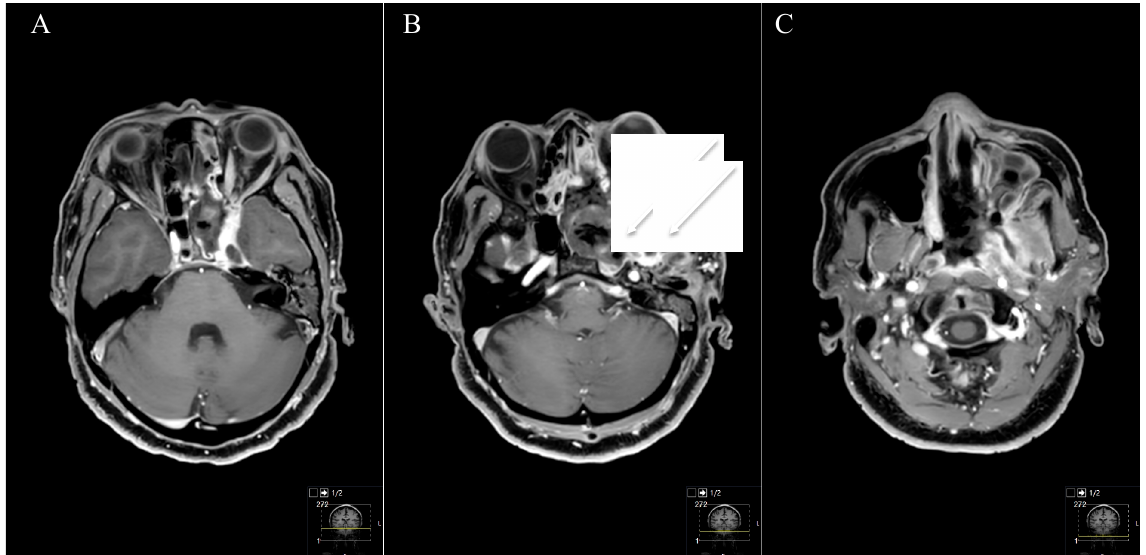
Figure 10. Postoperative outcome and MRI control (see Figure 9) ( A – C ) Postoperative axial T1-weighted gadolinium-enhanced MRI showing a satisfactory STR with small remnants in the maxillary sinus (arrows in ( B )). Resection was performed by an endoscopic transnasal approach using the tumor-related widened corridor to the maxillary sinus. The patient recovered very well, the visual impairment recovered subsequently, the abducens nerve palsy and the facial pain during follow-up as well. The trigeminal hypesthesia remained. The patient had follow-up controls without any progress.